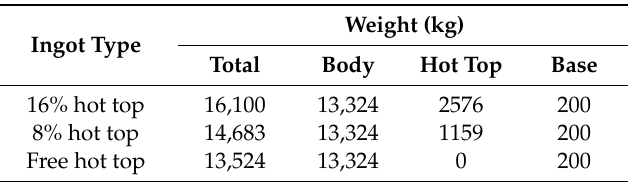
Figure 1. Schematic drawing of the ingot dimensions: ( a ) 16% hot top; ( b ) 8% hot top; ( c ) free hot top. Table 1. Weights of the ingots.